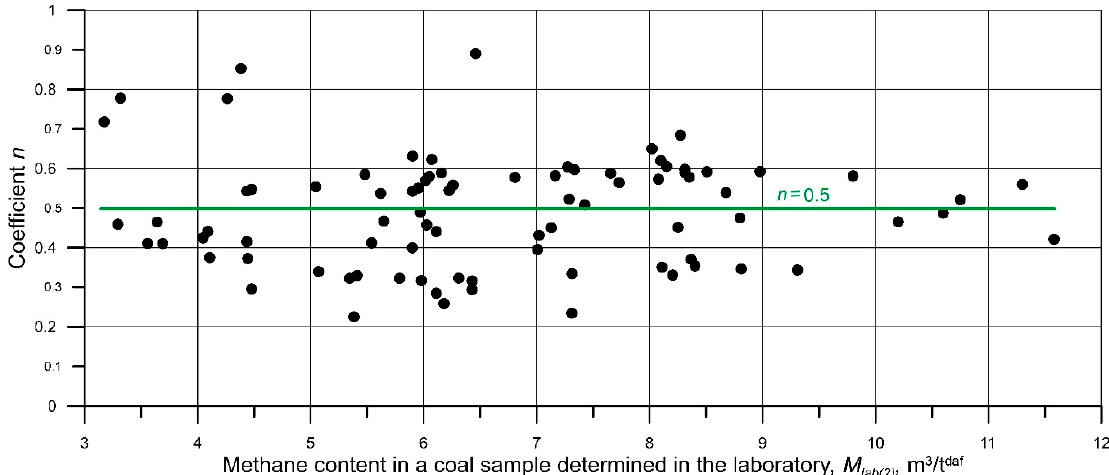
Figure 5. Relationship between coefficient n and methane content in coal samples in second minute of desorption M